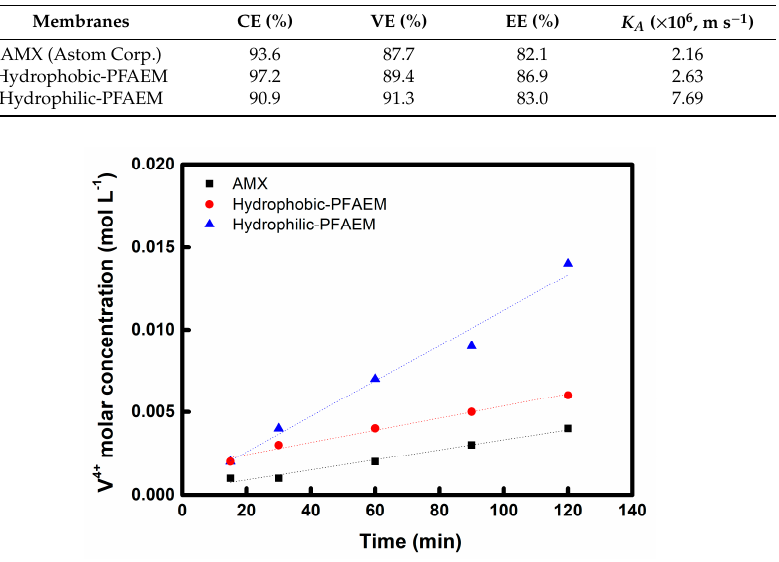
Figure 8. Time course change of vanadium ion transported through AMX, Hydrophobic-PTFE based PFAEM, and Hydrophilic-PTFE based PFAEM, respectively.